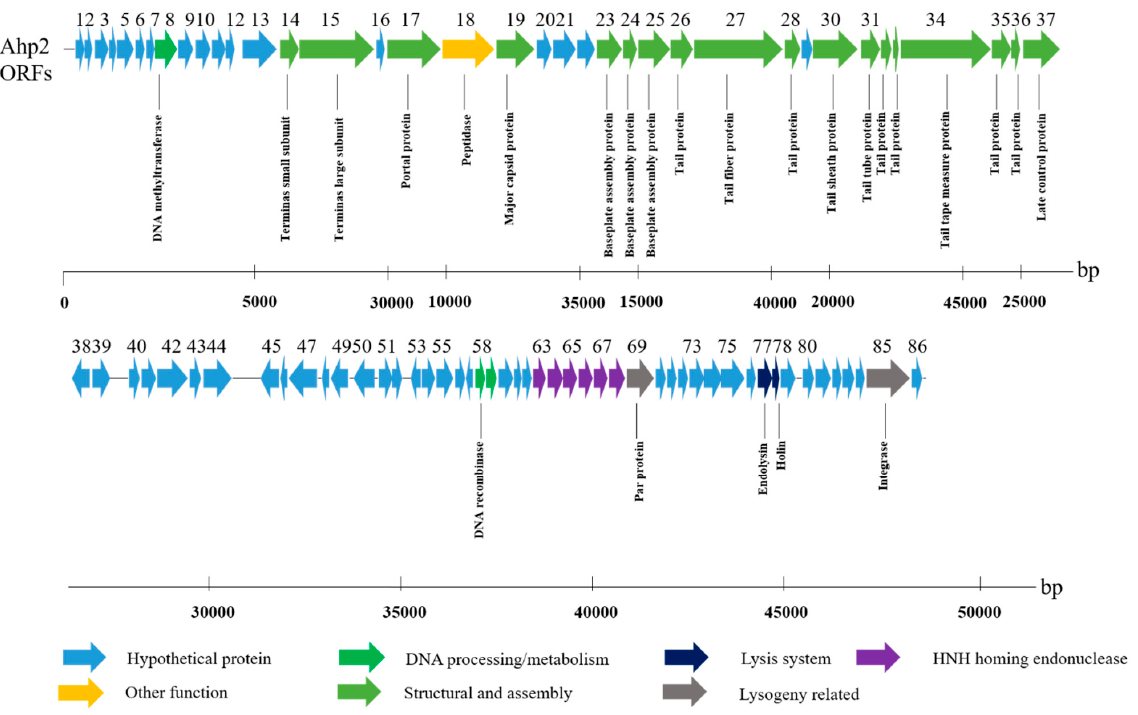
Figure 3. Annotated map of the Ahp2 genome. The predicted ORFs are numbered. Predicted gene functions are shown in different colors.